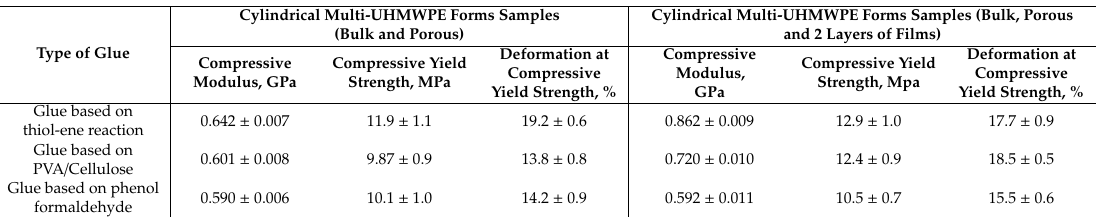
Table 3. Mechanical test results for the cylindrical multi-UHMWPE forms samples according to ASTM D-695.